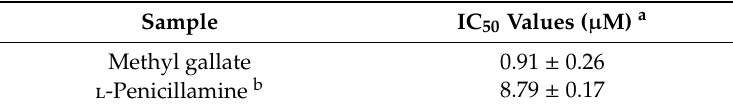
Table 6. ONOO − scavenging activity of methyl